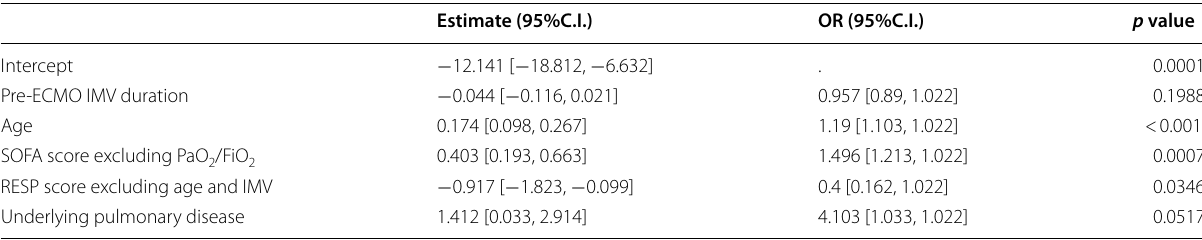
Table 4 Effect of pre‑ECMO IMV duration on ICU mortality in all patients with confounders age, modified SOFA, comorbidities, and modified RESP score